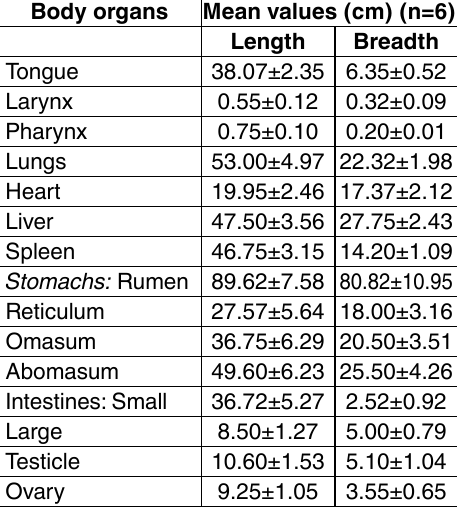
table 2. Biometry of some visceral and